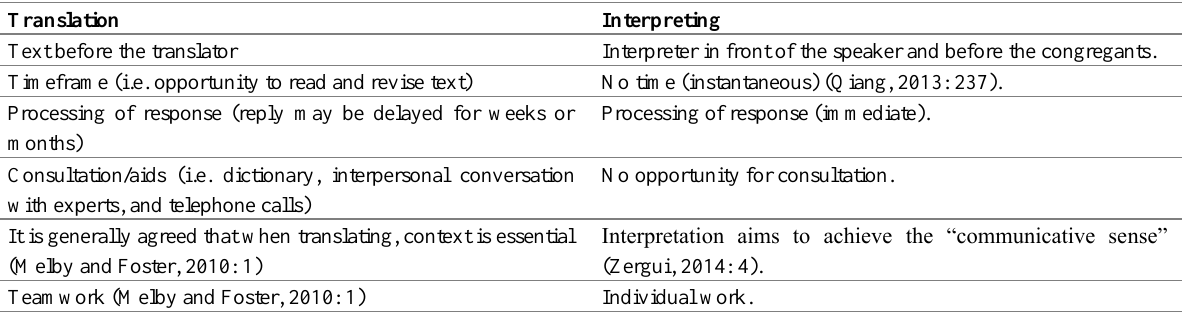
Table 1: Summary of The Two Terms “Translation” and